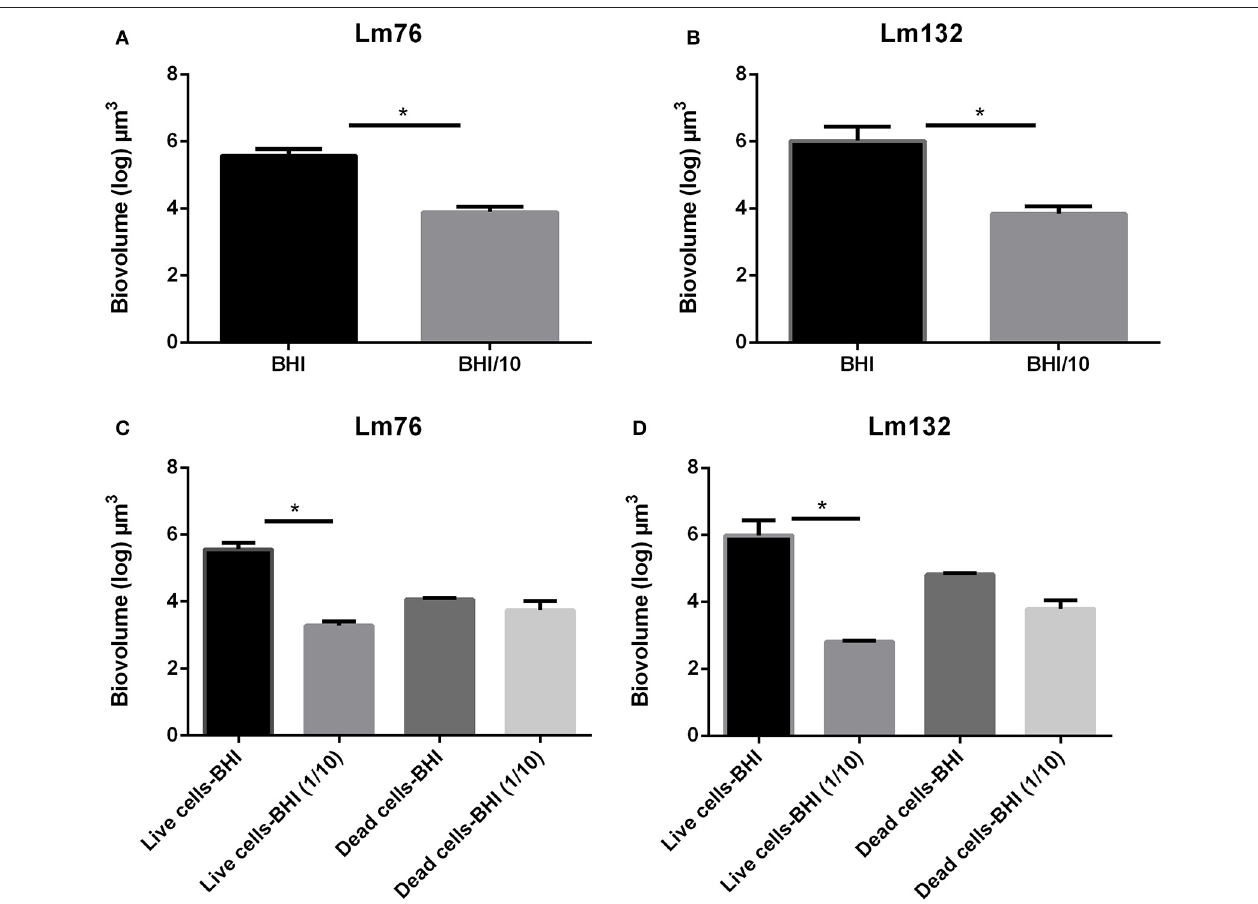
FIGURE 5 | Biovolume calculation of biofilm formed in static conditions by Listeria monocytogenes Lm76 and Lm132 strains grown in a rich medium BHI and poor medium BHI/10 for 24 h at 30 ◦ C; (A,B) Total biovolume of biofilm formation by Lm76 and Lm132 strains respectively which corresponds to some of the live and dead biomass in each biofilm; (C,D) Biovolume of live (green cells) and dead (red cells) biomasses in Lm76 and Lm132 biofilm respectively. * P < 0.05.